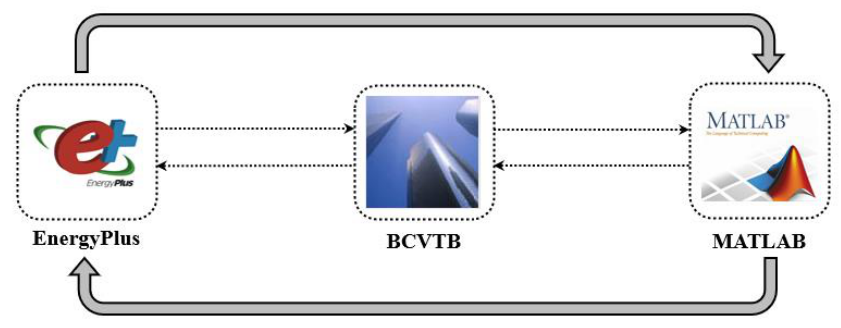
Figure 4. Conceptual diagram of integrated simulation.